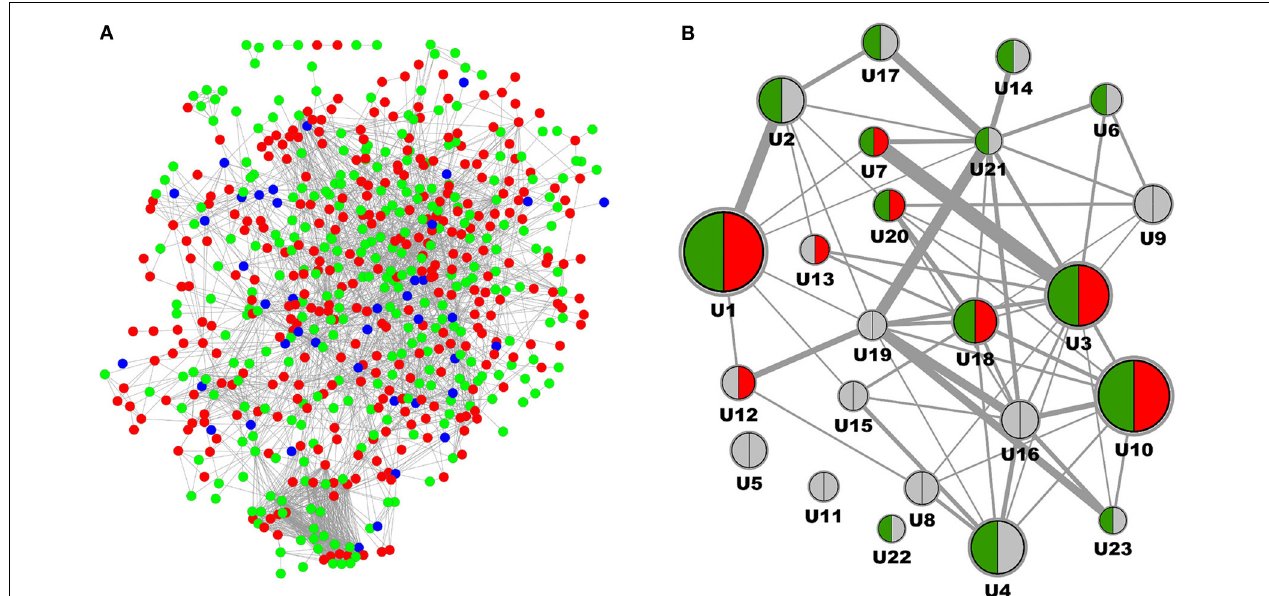
FIGURE 2 | Molecular model representation of diabetic nephropathy. (A) Induced subgraph where each node represents a protein coding gene being reported as associated with DN, edges denote interactions according to the underlying interaction network. Features derived from Omics studies are given in red, features delineated from literature mining are given in green, features identified in both data sources are depicted in blue. (B) Molecular